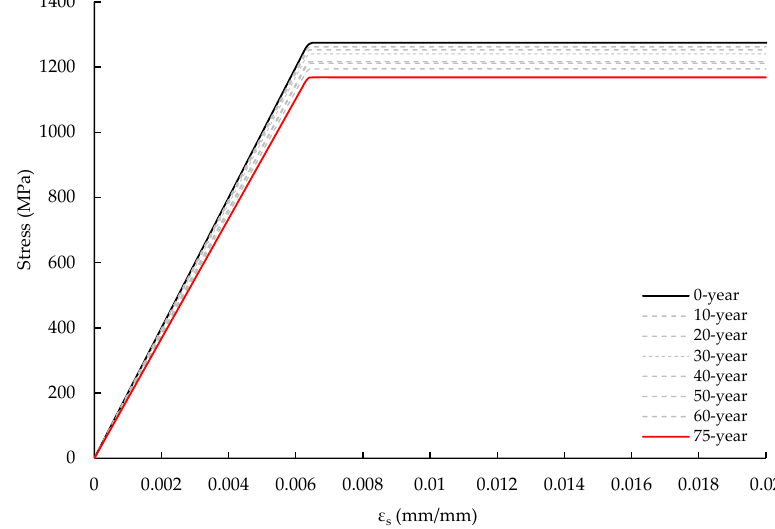
Figure 15. PC-bar stress–strain relationship.